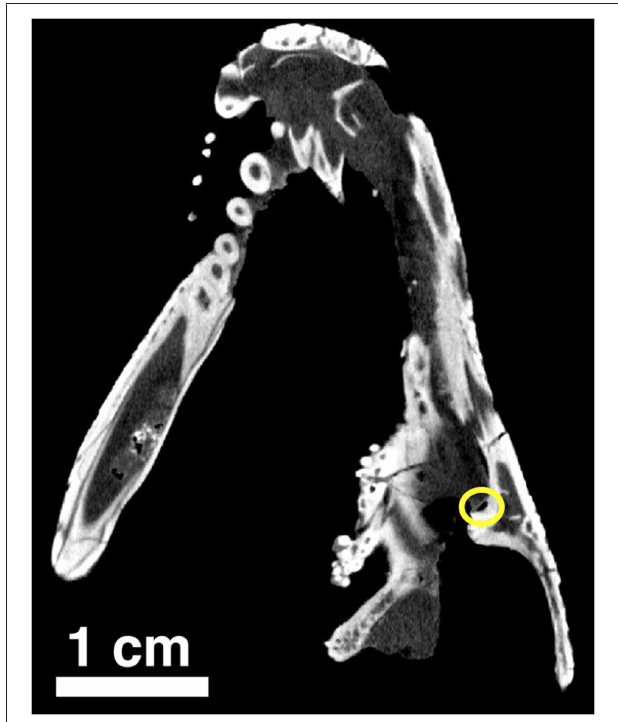
FIGURE 11 | Orthographic slice of the palatal region of Captorhinus kierani as seen through a neutron scan. The tip of the snout is at the top of the image. Note the region of the suborbital foramen surrounded by the yellow circle.